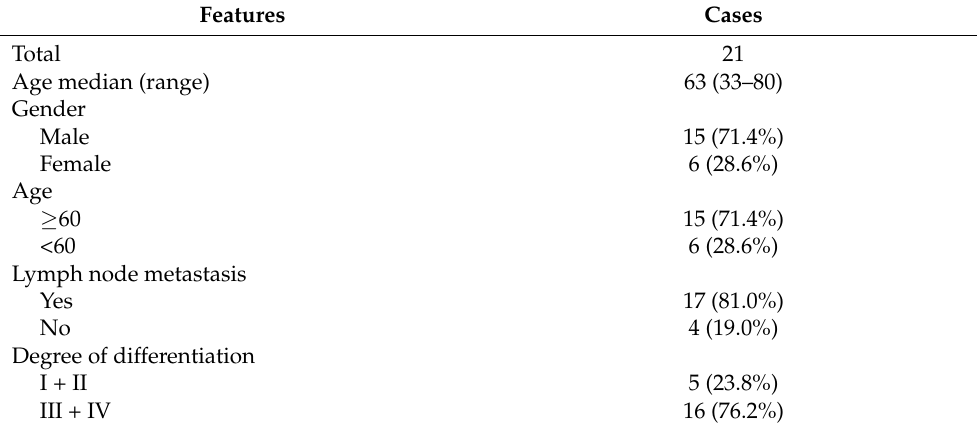
Table 1. Demographic and laboratory parameters of 21 gastric cancer patients included in the